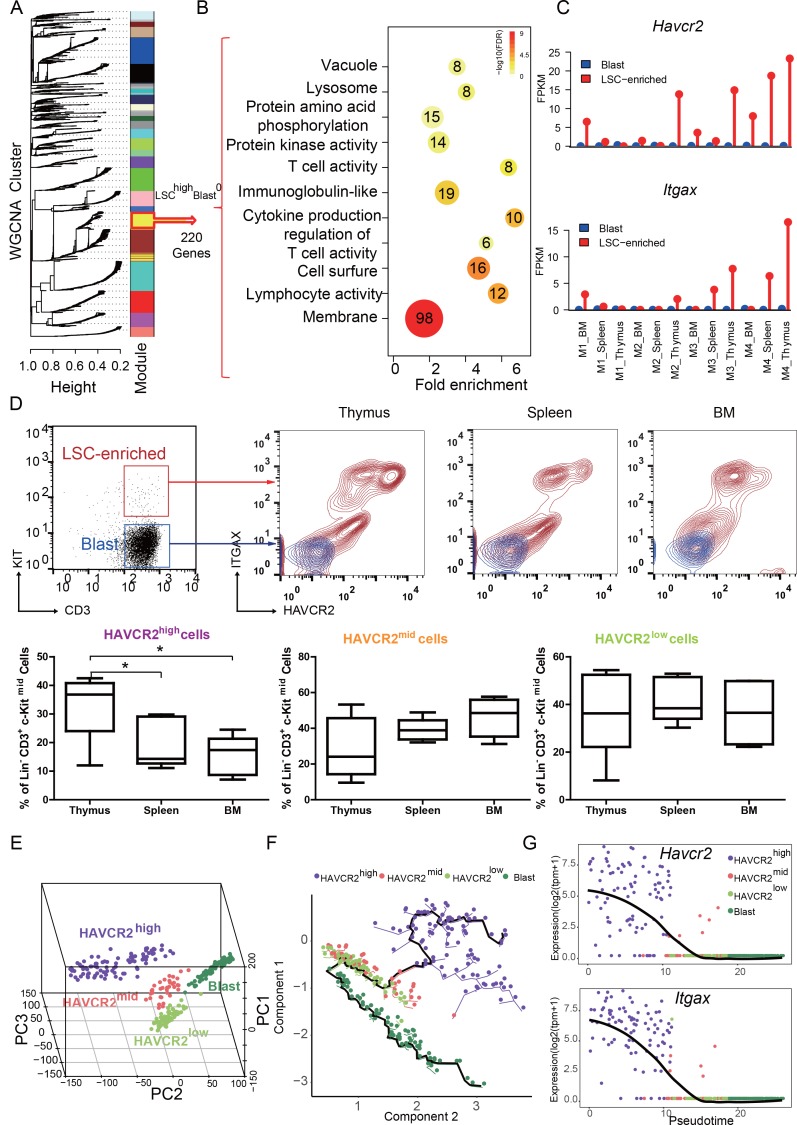
HAVCR2 redefines a heterogeneous LSC-enriched subpopulation at single-cell resolution (A) WGCNA analysis for the bulk RNA-seq of LSC-enriched and leukemic blast subpopulations.The yellow module contains 220 genes that are preferentially expressed in the LSC-enriched subpopulation (LSChigh-Blast0); (B) Gene Ontology (GO) analysis of LSC-enriched genes in the yellow module; (C) Havcr2 and Itgax are specifically expressed in LSC-enriched (red) but not in leukemic blast (blue) subpopulations isolated from the indicated hematopoietic organs of M1-M4 Pten-null T-ALL mice; (D) Upper panel: FACS plots are overlaid to show the differential expression of HAVCR2 and ITGAX in the LSC and blast subpopulations. The previously defined Lin-CD3+KITmid LSC-enriched subpopulation (in the red box in the left panel) can be further separated into several subgroups based on the expression of the cell-surface markers HAVCR2 and ITGAX. The Lin-CD3+KIT- leukemic blast subpopulation (in the blue box in the left panel) does not express HAVCR2 or ITGAX. Lower panel: Quantitative measurement of the HAVCR2high, HAVCR2mid and HAVCR2low subgroups in different hematopoietic organs from Pten-null T-ALL mice (n = 5; *, p<0.05). The HAVCR2high subgroup is enriched in the thymus; (E) PCA analysis of the single-cell transcriptome shows four subgroups, labeled in different colors. Cells from two independent mice are indicated by different shapes; (F) Pseudotime analysis shows the expression profiles of T-ALL cells in 2-D component space. The solid black line shows the main differentiation path from HAVCR2high (purple) to blasts (dark green); (G) Pseudotemporal ordering of single cells based on Havcr2 or Itgax expression.BM: bone marrow.